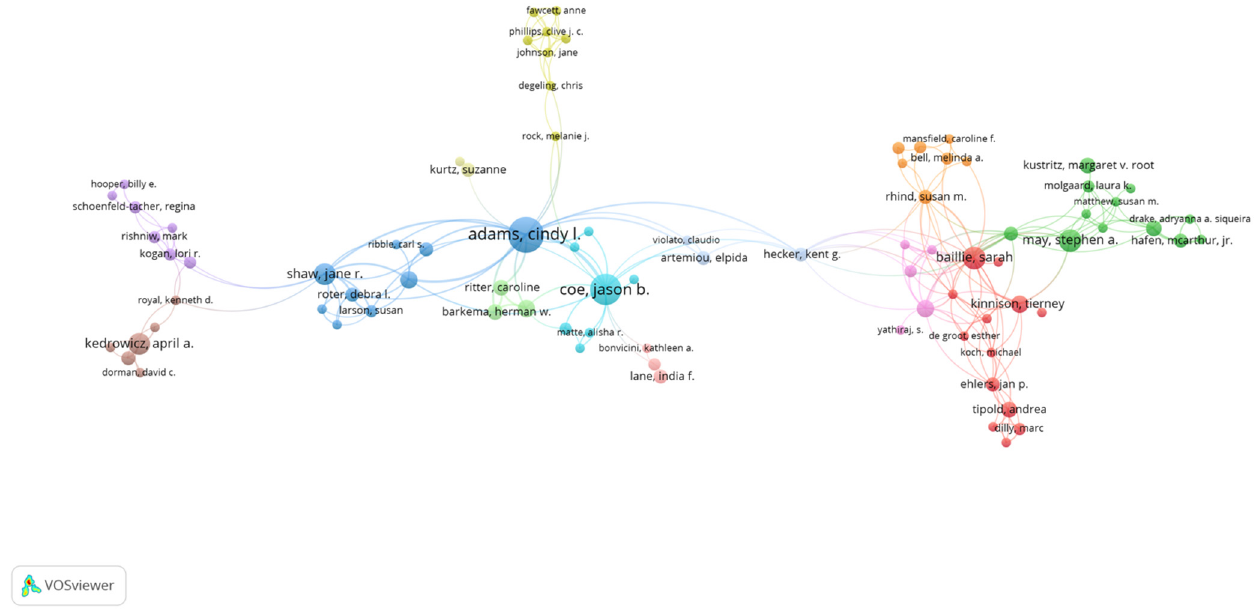
Figure 7. Author collaboration analysis of 677 veterinary communication education publications (VCEPs) from 2000 to